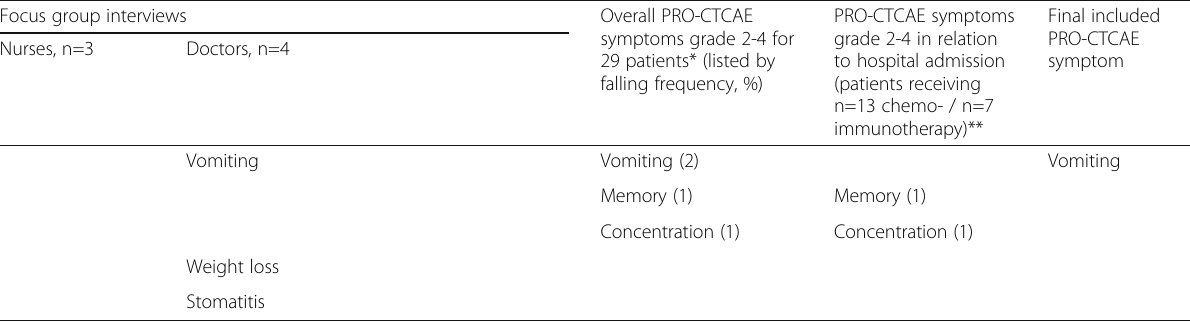
Table 2 Final PRO-CTCAE Item Selection Process (Continued) Focus group interviews Overall PRO-CTCAE